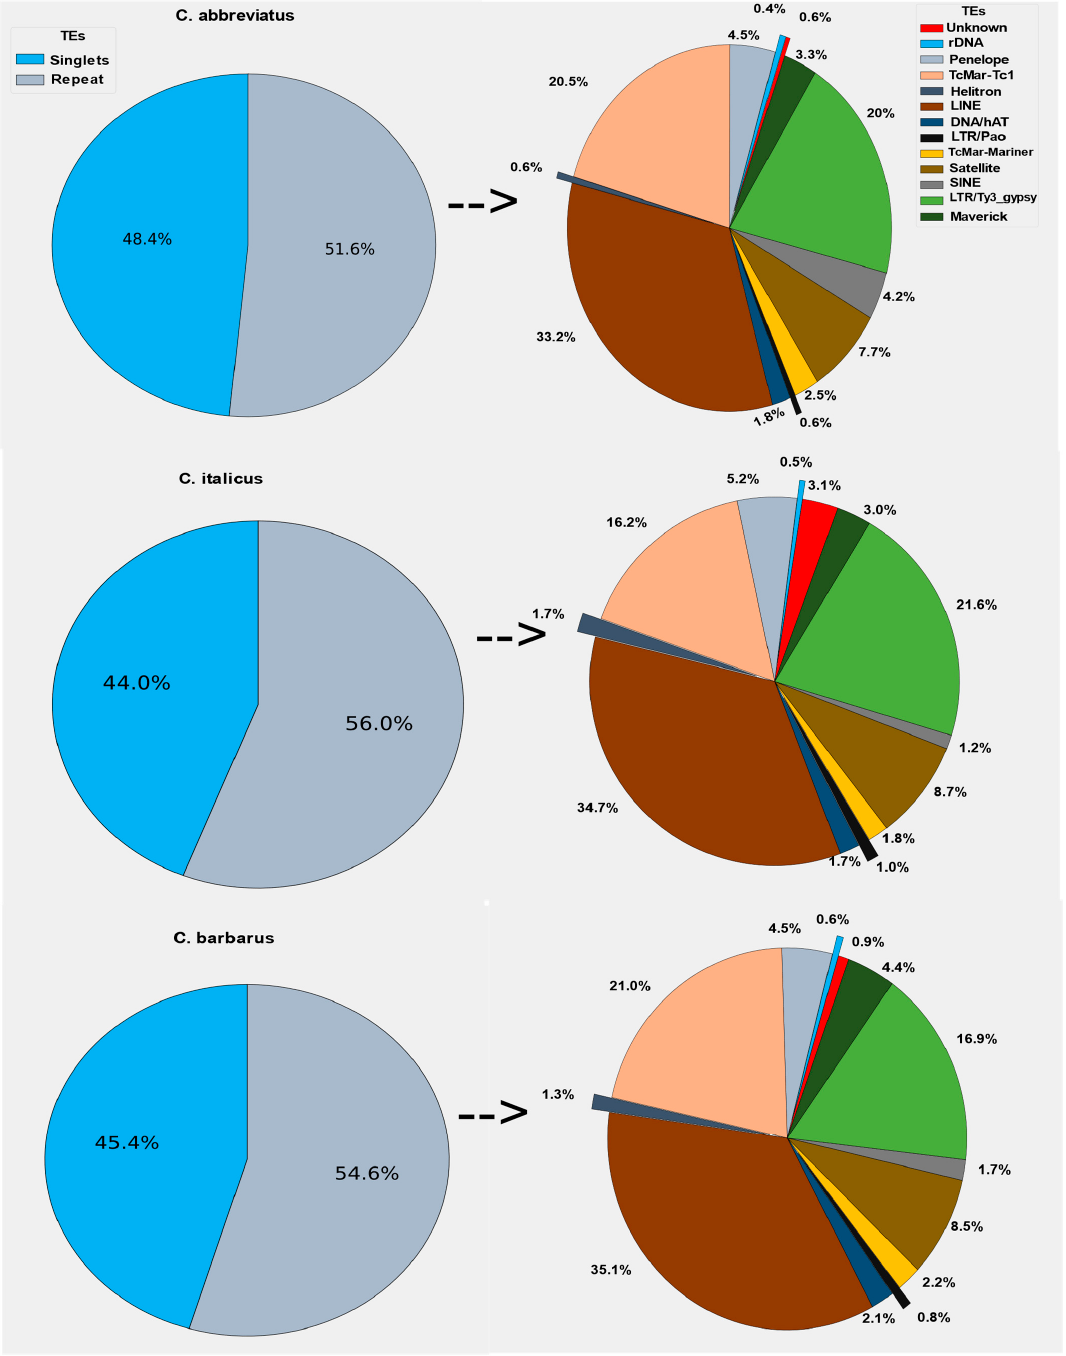
Figure 1. Genome composition of repetitive DNA sequences and singlets or unique sequences of three Calliptamus species. The genome repetitive part was dominated by LINE, LTR/Ty3_gypsy, and TcMar-Tc1 families.